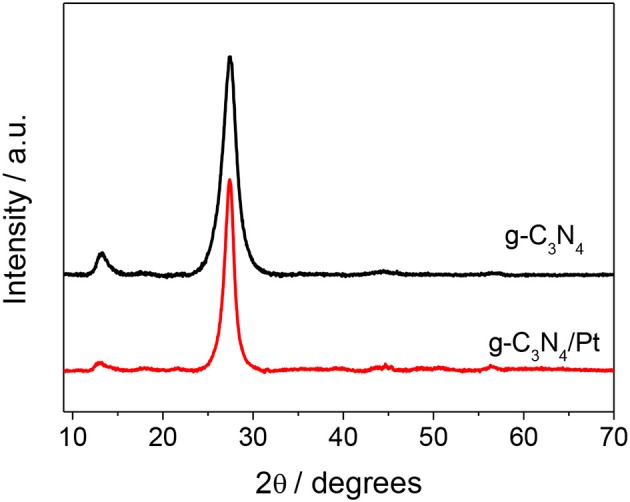
XRD patterns of g-C3N4/Pt sample and g-C3N4 reference.